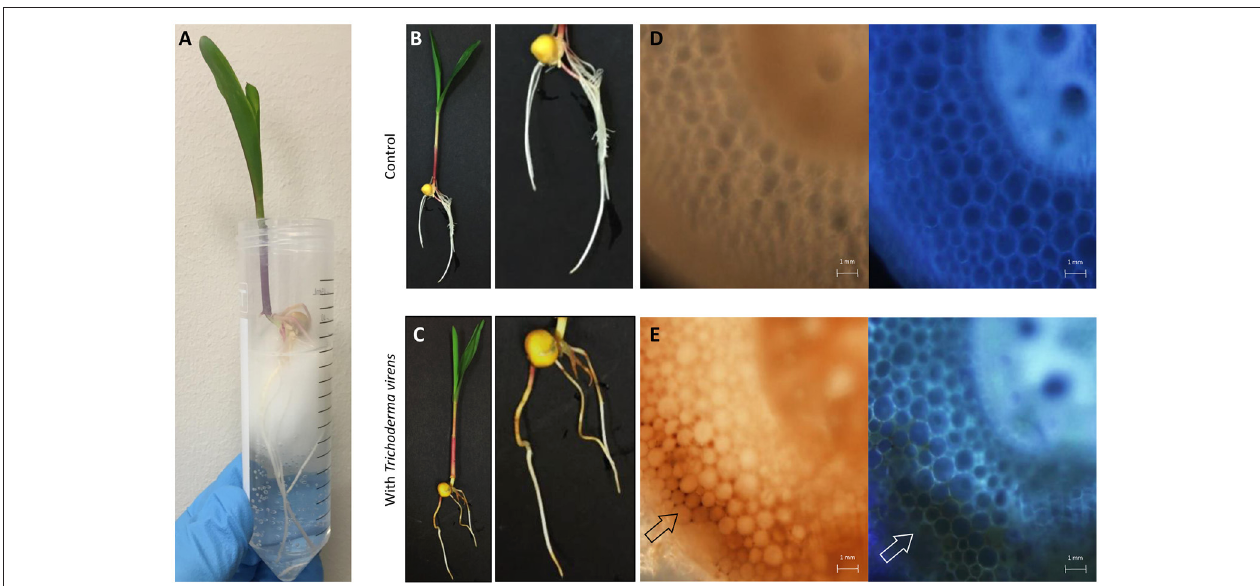
FIGURE 1 | Overview of T. virens -maize interaction under a hydroponic system. (A) Five day old maize seedling growing aseptically under hydroponic conditions. (B) Un-inoculated and (C) inoculated plants with T. virens . Inoculated plants show phenotypical changes in their root system compared to the control. Cross section of un-inoculated primary root (D) bright-field and DAPI. Cross section of inoculated primary root (E) showing accumulation of brown pigmentation in epidermal and cortical cells, bright-field and DAPI. Images were obtained with a fluorescent